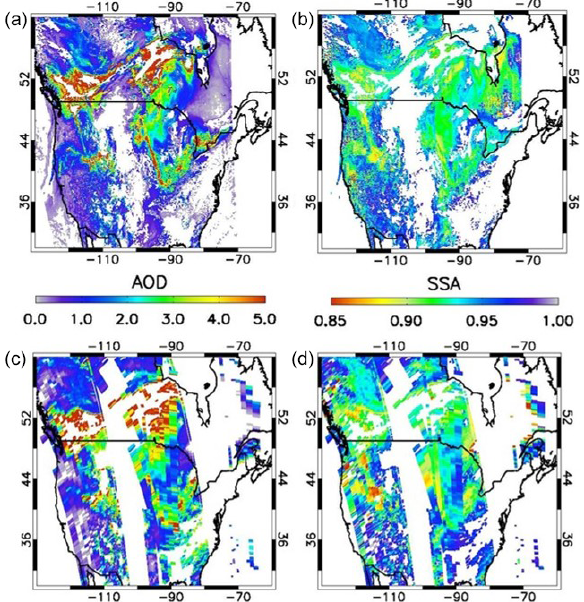
Figure 9. Spatial distribution of 388nm AOD (a, c) and SSA (b, d) on 18 August 2018 derived from TROPOMI (a, b) and OMI (c, d)